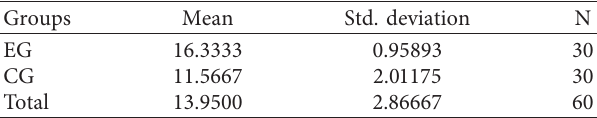
Table 3: Descriptive statistics (both groups’